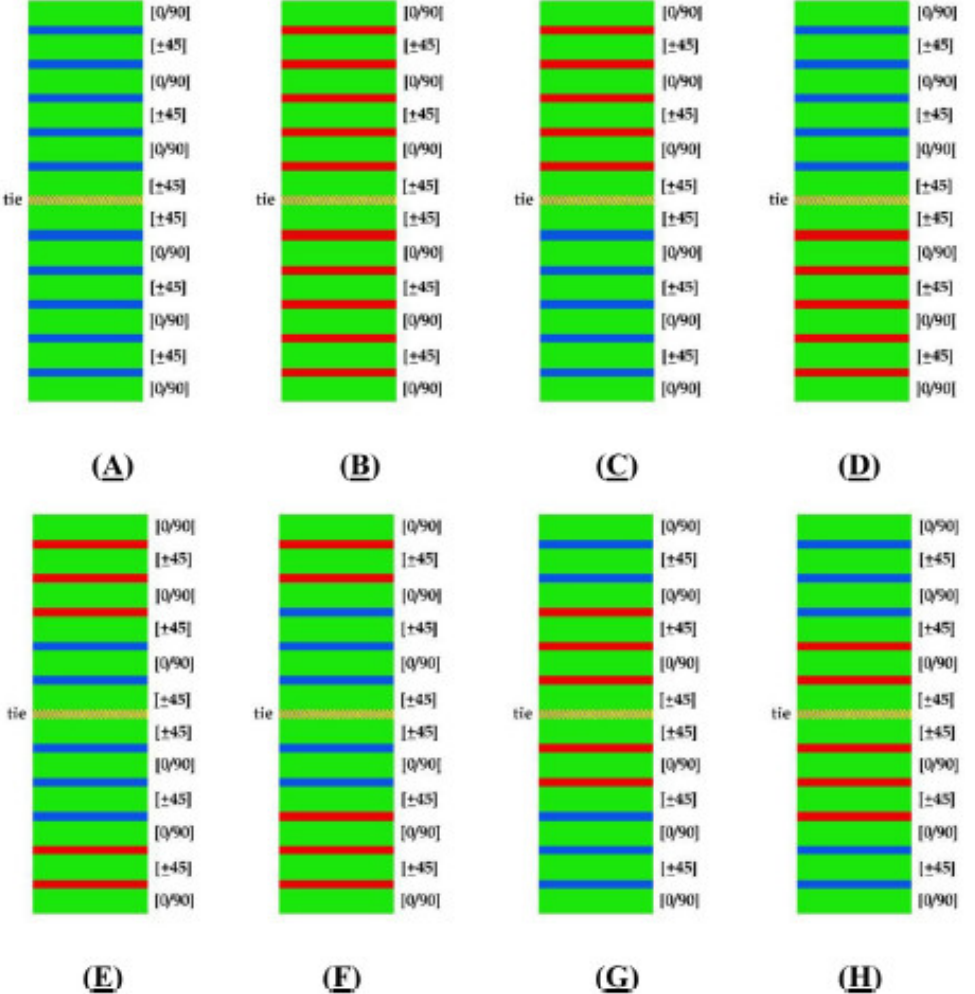
Figure 6. Different interleaf sequences used for considering their effect on delaminated area (blue areas belong to reference layer and red areas belong to nano-modified layer) [19] .